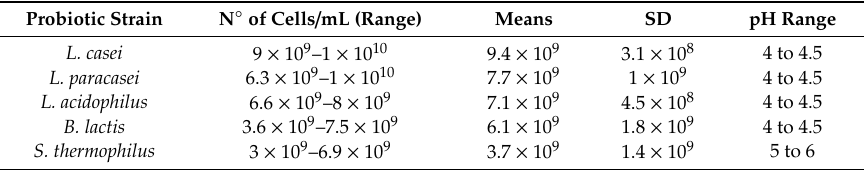
Table 1. Cells / mL and pH range after 20-h overnight culture.